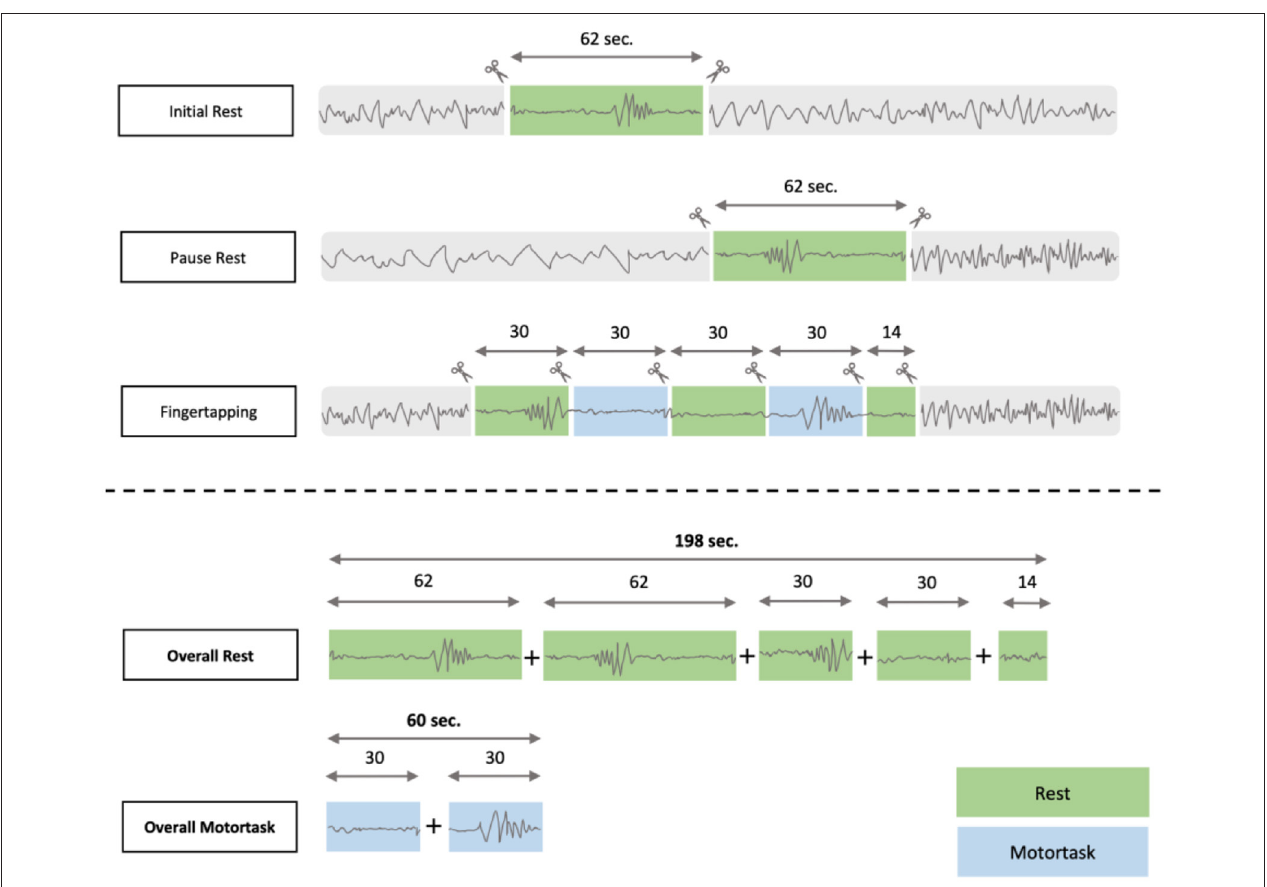
FIGURE 1 | EEG- segmentation process: The overall time for resting was 198 seconds compared to 60 seconds of motortask related EEG segments.